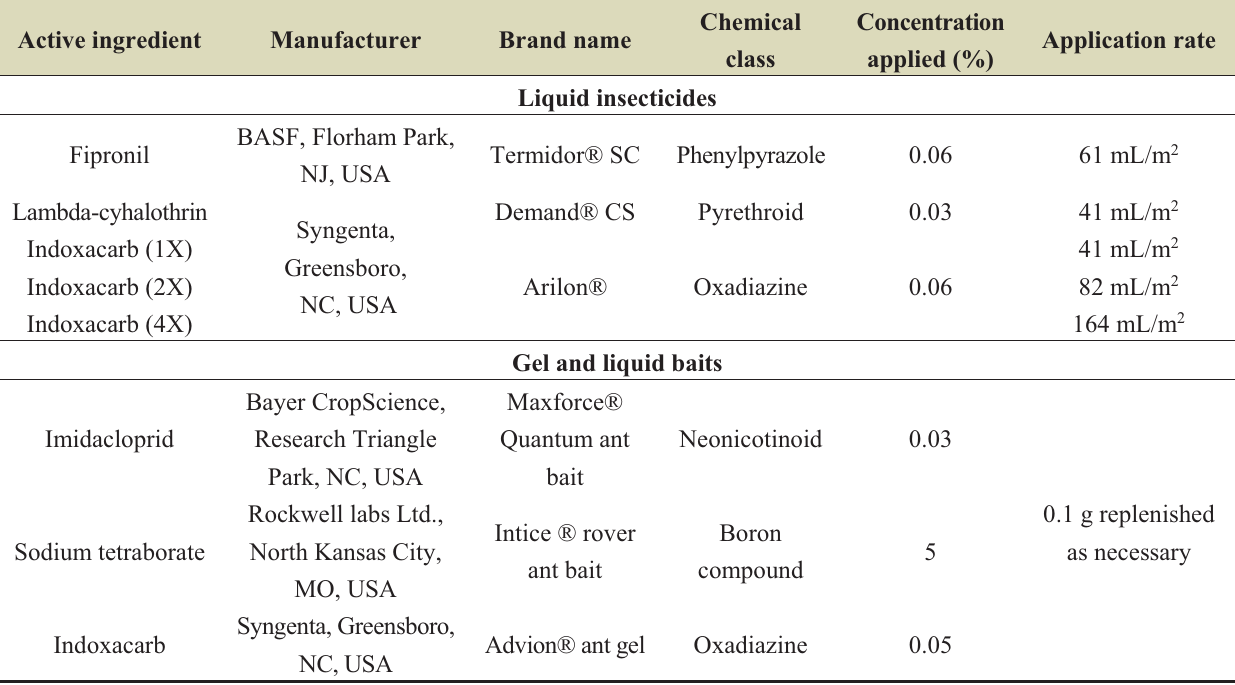
Table 1. Details of the insecticide formulations